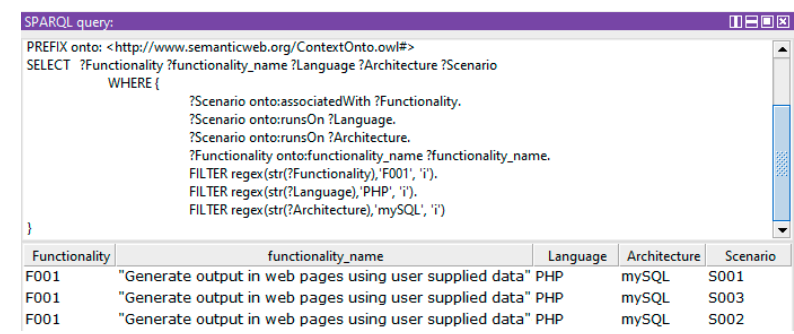
Figure 9. An example of SPARQL (to query Scenarios).